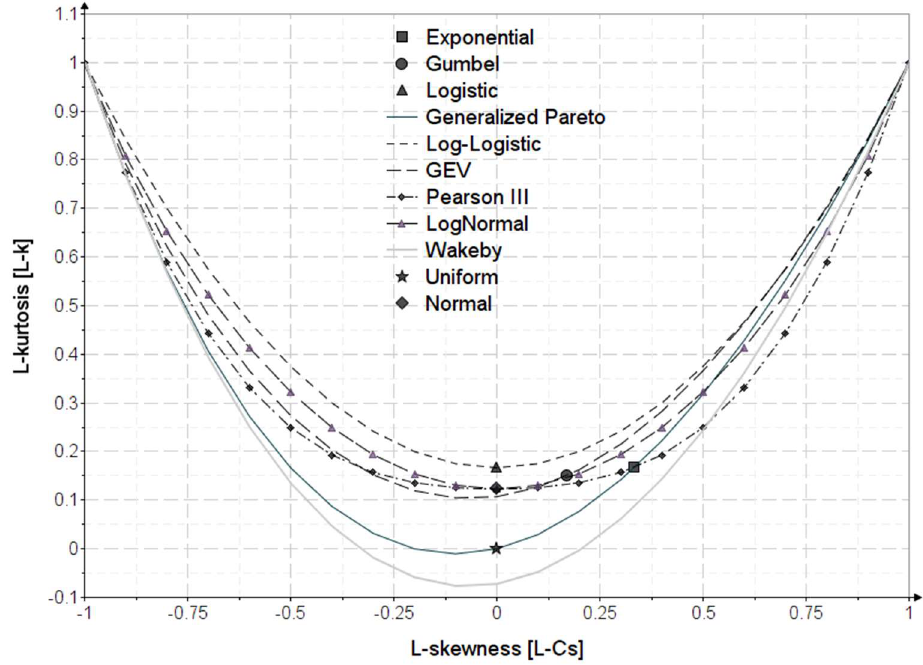
Figure A1. The variation of L-kurtosis–L-skewness.